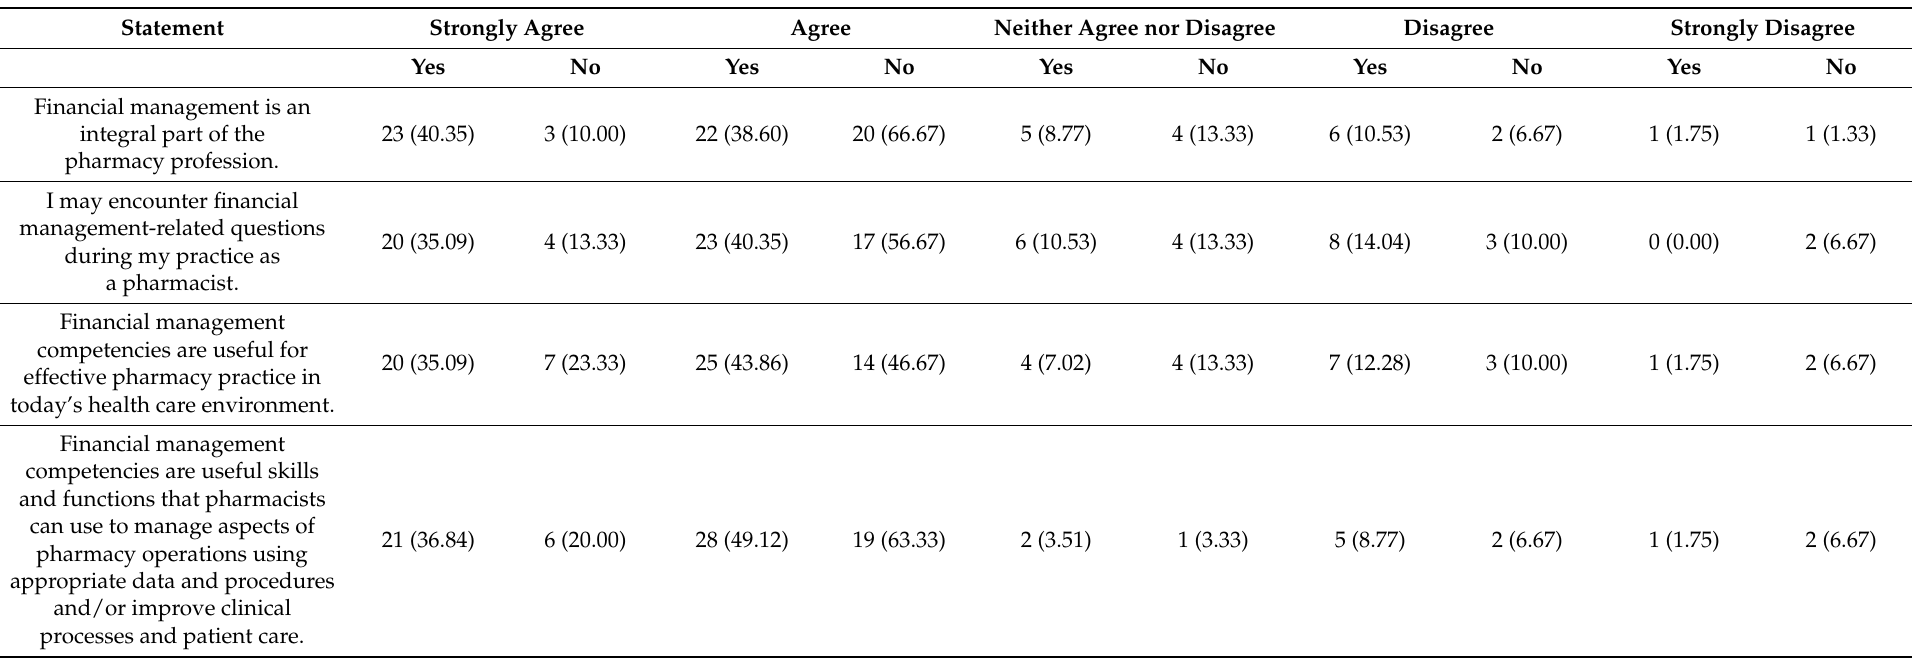
Table A2. Perception of the clinical relevance of pharmacy financial management education (N = 139) by business related courses prior to pharmacy school (N =